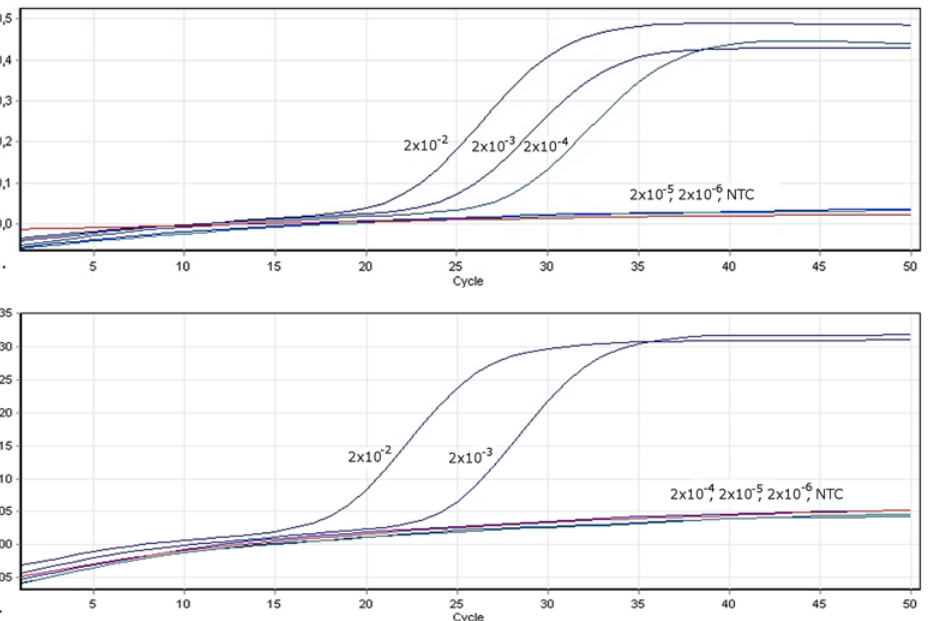
Fig 4. Results of LAMP reactions using real-time monitoring with different dilutions of DNA template. a) DNA extracted from one larva; b) DNA extracted from one adult specimen. NTC — no template control.